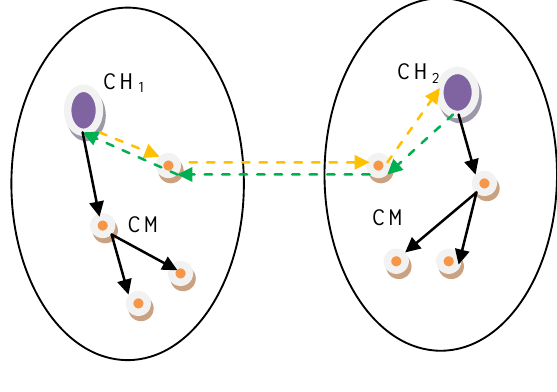
Figure 1. Illustration of Cluster Formation Cluster is formed from the signal delay value and signal strength. Shortest path lies between CH and CM. Each cluster members initiates and supports route discovery process and estimate link strength. Only those nodes which is having maximum cluster member count and signal strength, it is qualified to join cluster